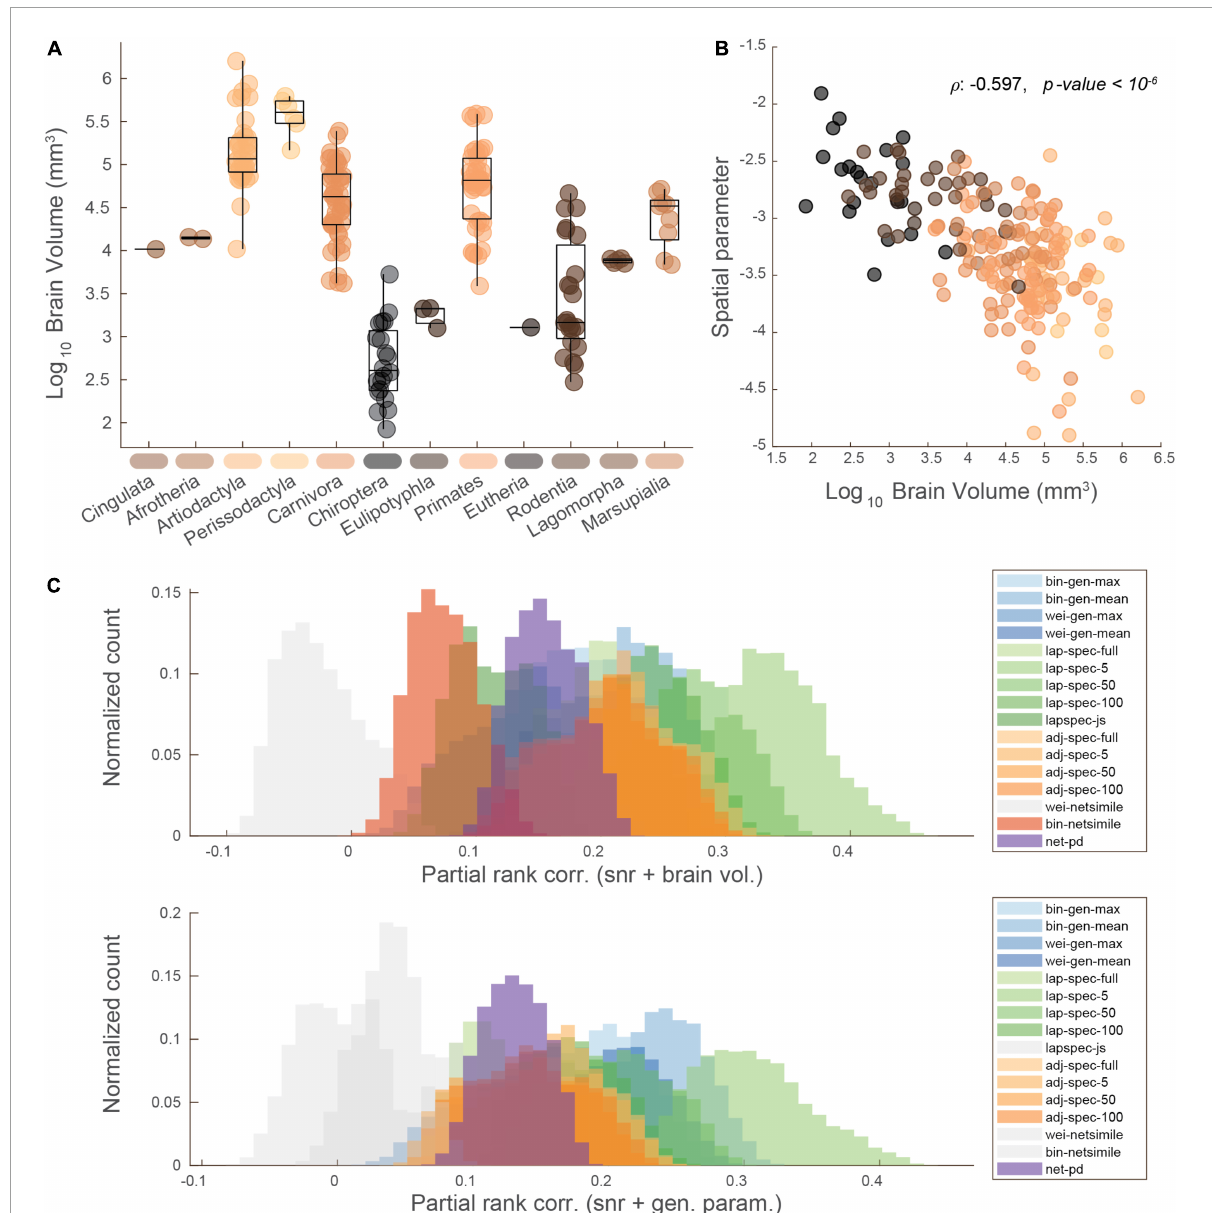
FIGURE4 Accounting for potential confounds in network vs. phylogeny distance correlations. (A) Mammals log 10 brain volume for each order; points colored by brain volume magnitude. (B) Brain volume plotted against a generative spatial parameter, showing how larger brains’ connectivity patterns are more influenced (more negative) by the distance between connections; points colored by brain volume magnitude. (C) Similar rank correlation distribution plots as shown in Figure 3 , but with signal-to-noise and brain volume (upper) or the generative spatial parameter (lower) regressed out. Rank corr: spearman correlation; gen. param: spatial generative modeling